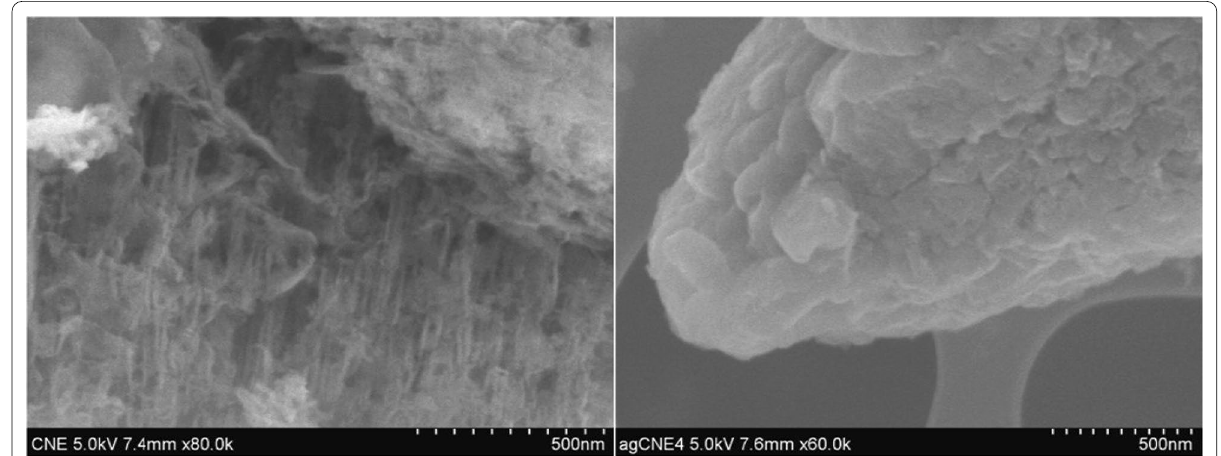
Fig. 10 SEM micrographs of CNE (left) and AgCNE4 (right)